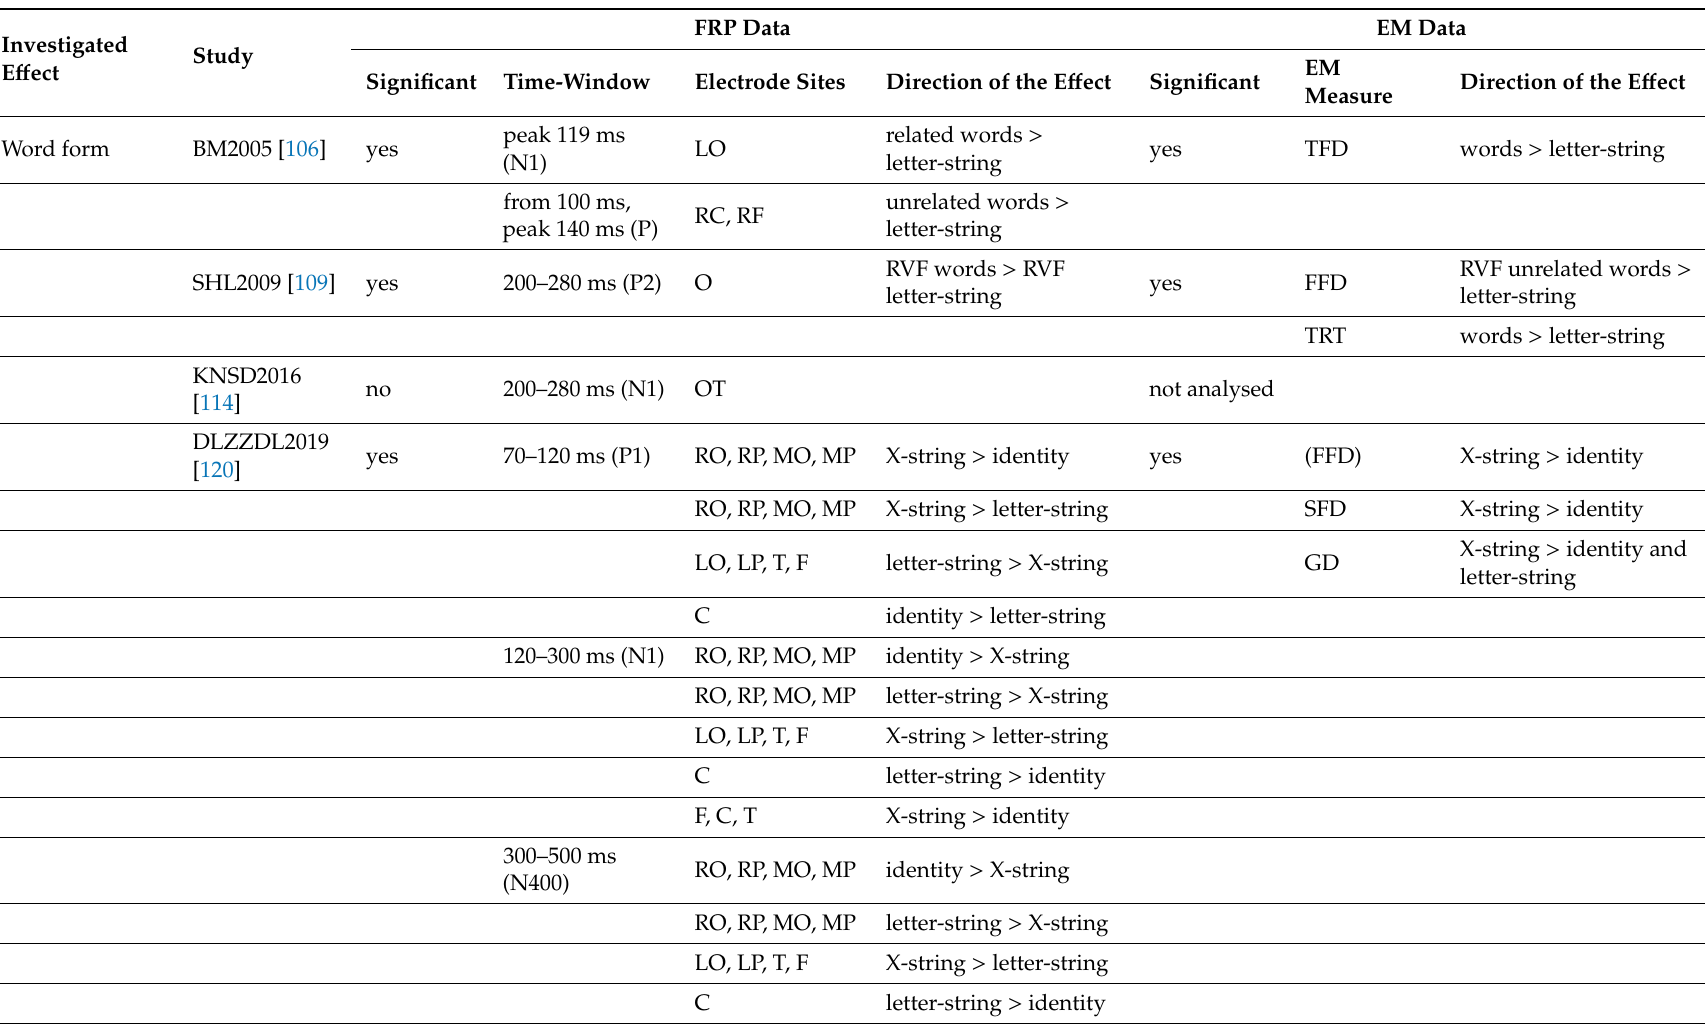
Table 2. Summary of the Findings Reported in Co-Registration Studies Investigating Parafoveal-on-Foveal (PoF) E ff ects. In these studies, the parafoveal word was manipulated, and the eye movements (EM) and fixation related-potentials (FRP) data were time-locked to the fixation onset on the pretarget word. Thus, these results are associated with e ff ects derived from parafoveal manipulations measured during fixation on the pretarget word.